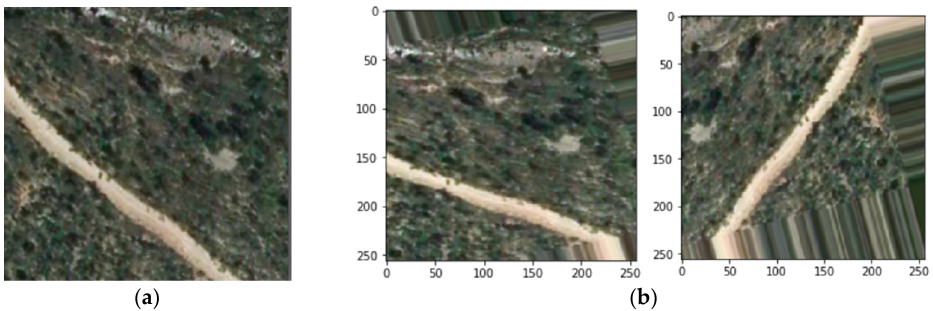
Figure 2. Data augmentation process: ( a ) Original tile; ( b ) Transformed tiles (rotated, flipped, zoomed).